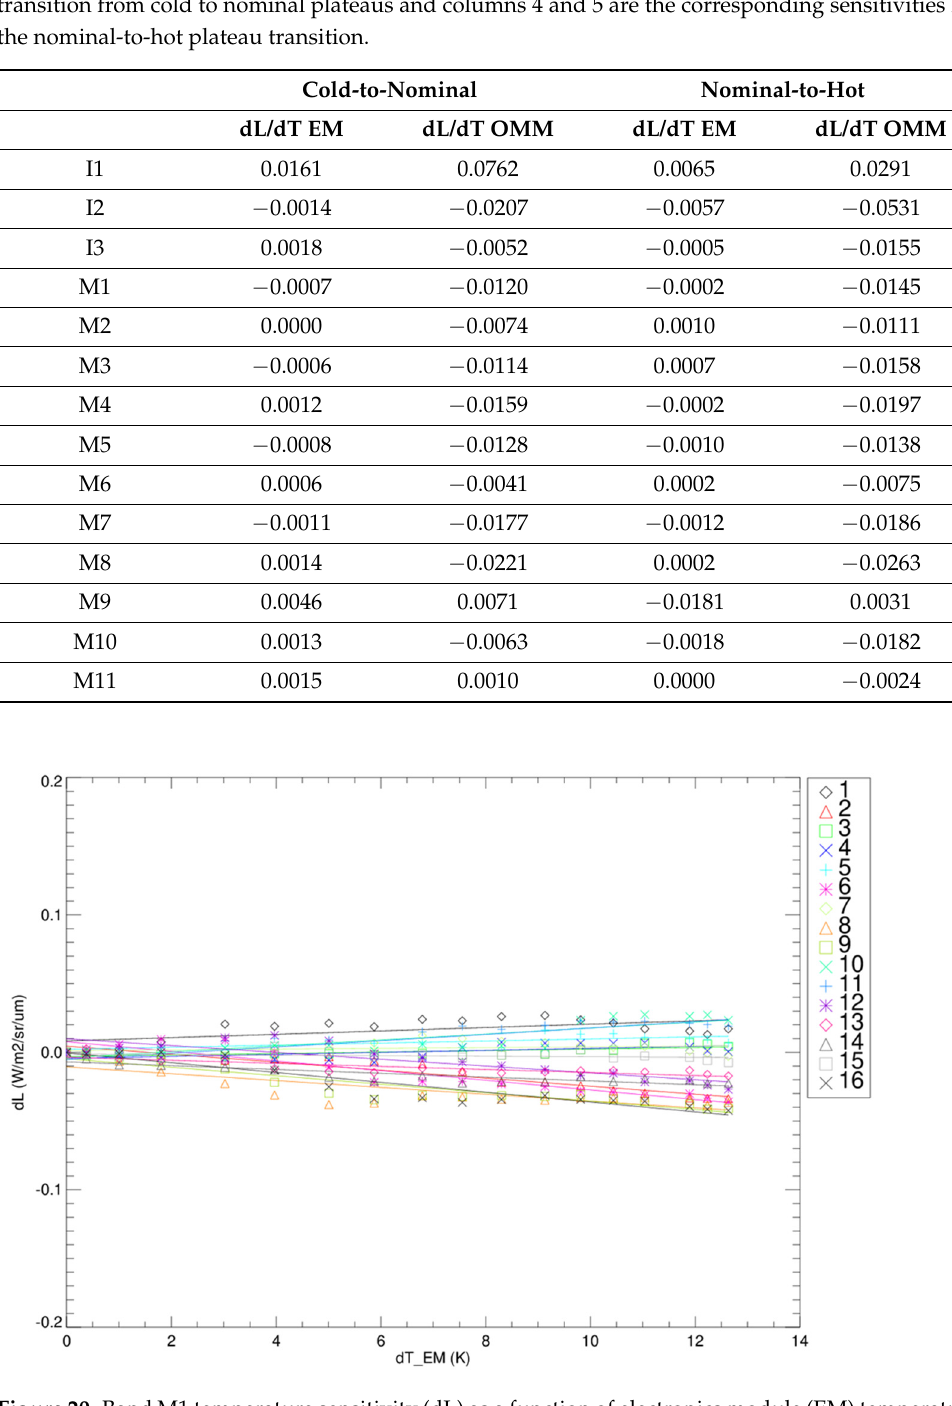
Figure 20. Band M1 temperature sensitivity (dL) as a function of electronics module (EM) temperature change between nominal and hot plateau for each detector (colors and symbols).